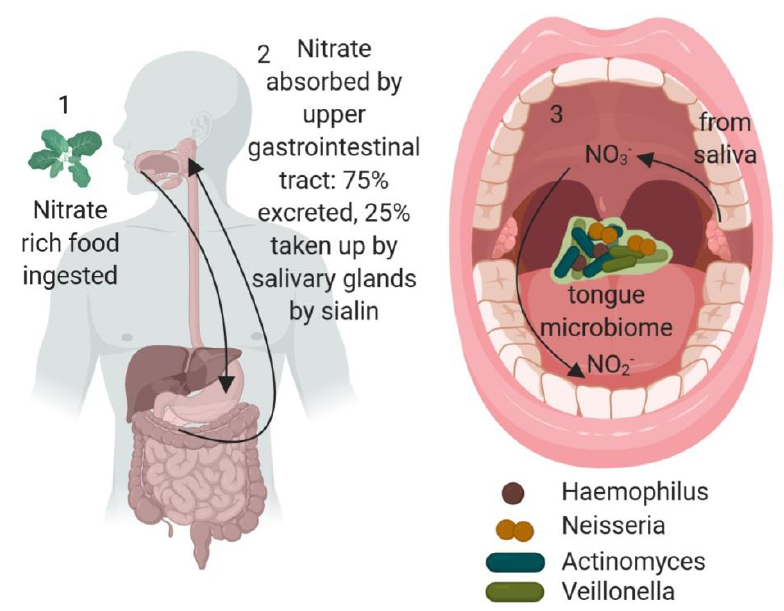
Figure 1. Enterosalivary nitrate production and the role of the oral microbiome. 1. Nitrate-rich food, such as leafy green vegetables, is ingested. 2. Nitrate is absorbed in the upper gastrointestinal tract and 25% is then found in saliva due to the action of the sialin anion transporter. 3. The oral microflora, particularly nitrate-reducing bacteria, such as Actinomyces, Haemophilus, Neisseria and Veillonella , residing in the dorsal tongue biofilm convert nitrate to nitrite, and also to nitric oxide (NO) which can be absorbed through the vascularized tongue or through swallowing back in to the gastrointestinal system for absorption. Image created in Biorender.